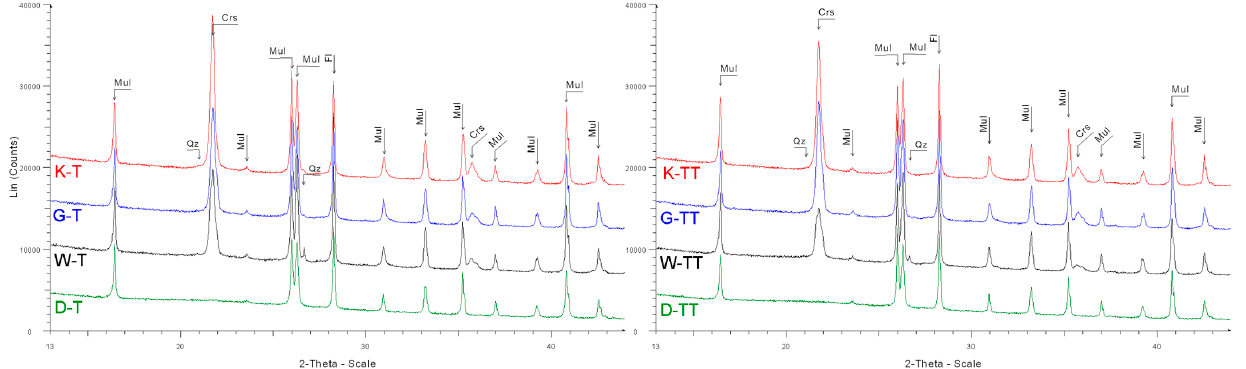
Figure A6. Diffractograms of samples after one (T) and two (TT) cycles of firing in industrial tunnel furnace; fluorite was used as an internal standard. Materials 2021 , 14 , x FOR PEER REVIEW